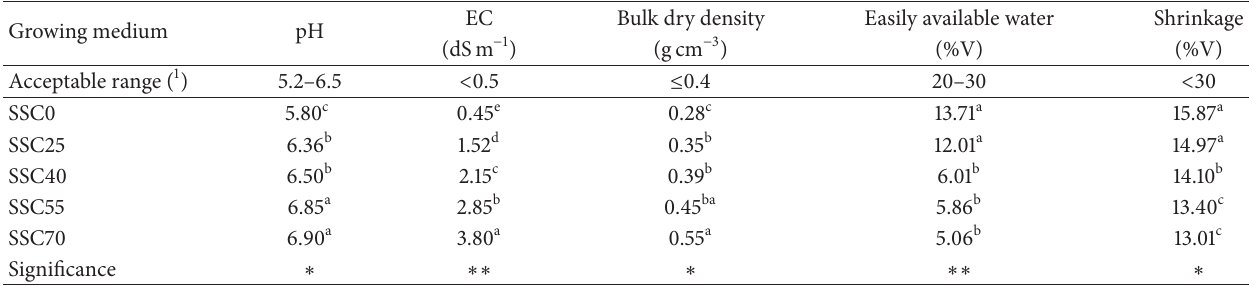
Table 4: Physical and physicochemical characteristics of the growing media used (at transplant).